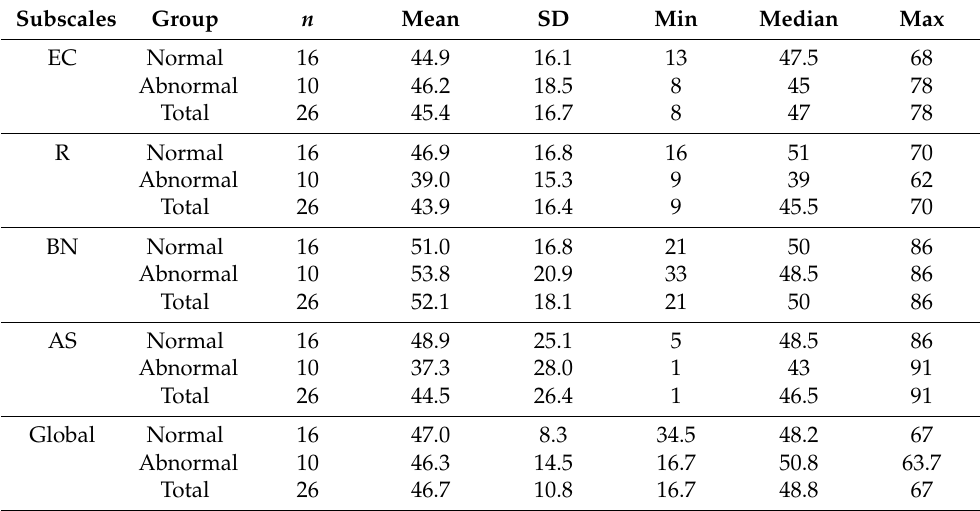
Table 6. Descriptive statistics for APHAB subscales and global values when comparing the Normal and Abnormal